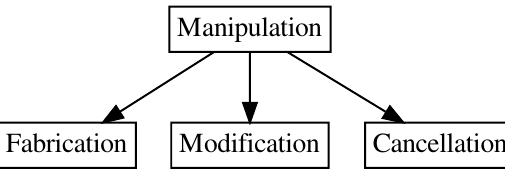
Figure 3. Manipulation techniques classification.